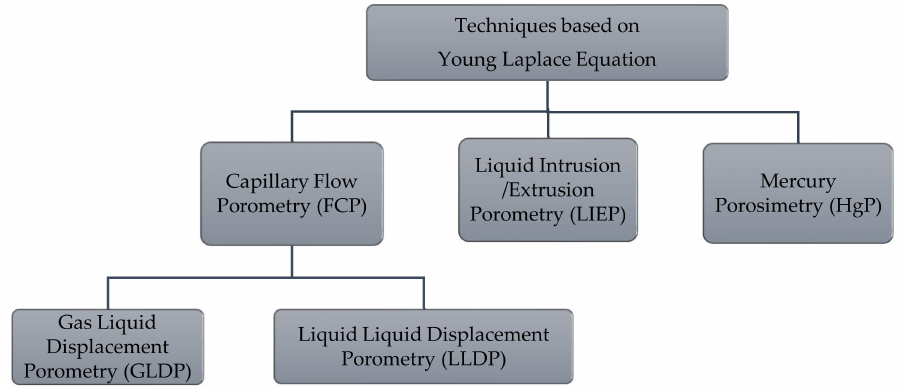
Figure 1. Young–Laplace-based